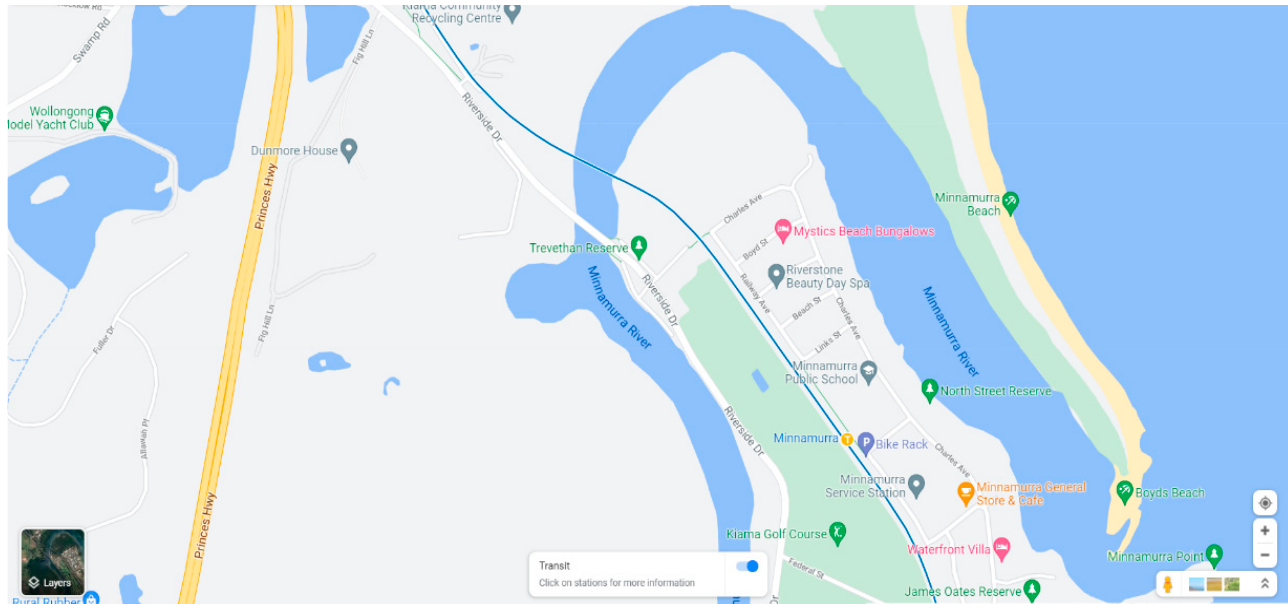
Figure 5. The location of the Minnamurra Railway Bridge (Google Maps).